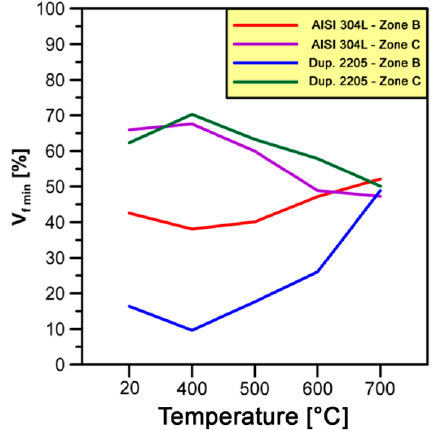
Figure 12. Relationships between the minimum deformed volume fractions ( V f min ) and forging temperatures evolved under cold-to-warm deformation of γ -phase in AISI 304L and Duplex 2205 stainless steel.